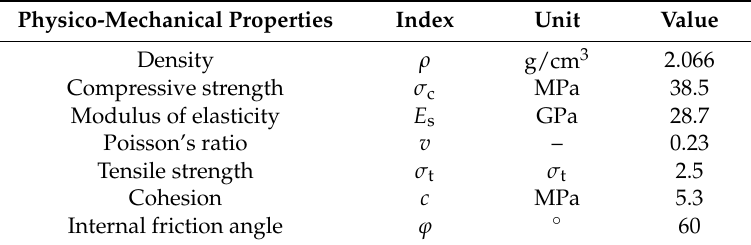
Table 1. Physico-mechanical